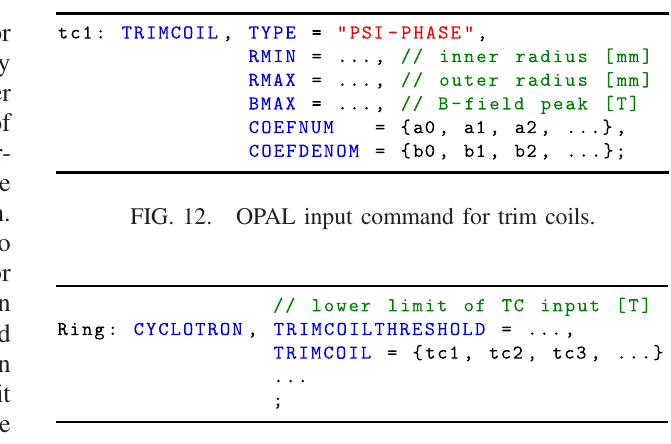
FIG. 13. Additional trim coil input arguments for the cyclotron element definition in